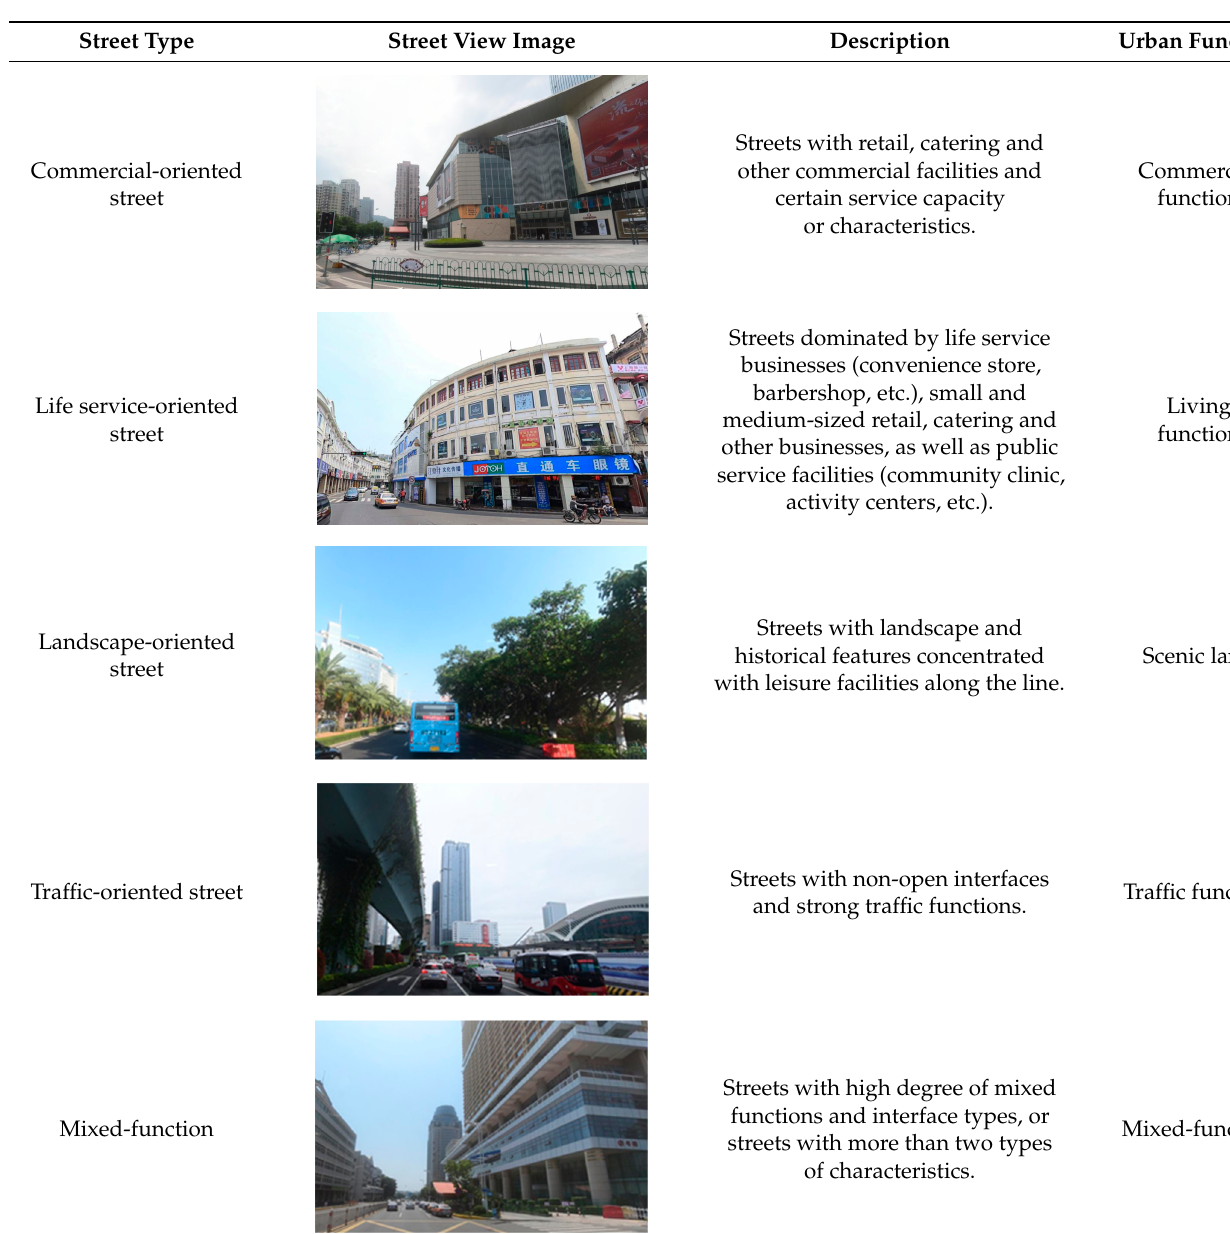
Table 2. Street types and the corresponding urban functions.